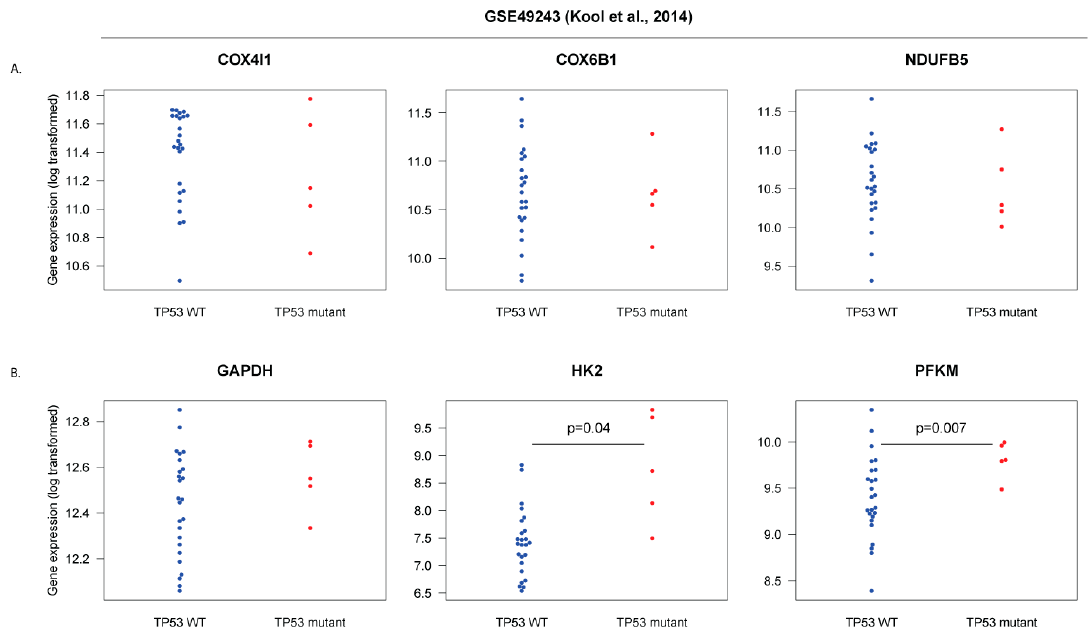
Figure 10. Expression of markers of mitochondrial oxidative phosphorylation ( A ) and glycolysis ( B ) in SHH-medulloblastoma (MB) tumors genotyped for mutations in the TP53 gene. Microarray data from the GEO dataset GSE49243 was cross-referenced with supplemental data from [7] to obtain expression data in TP53 WT and TP53 mutant subgroups. Log2 expression is shown for each subgroup for the indicated genes.